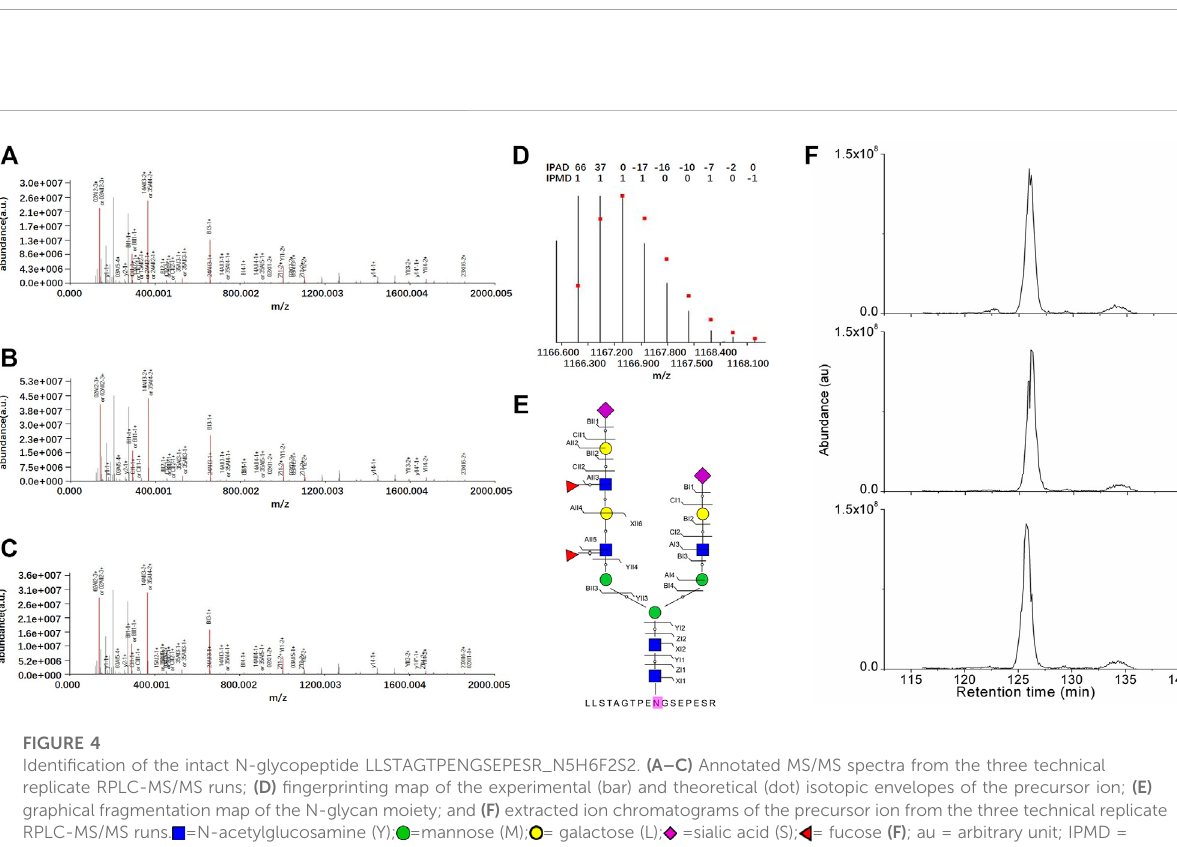
FIGURE 3 Identi fi cation of the intact N-glycopeptide GNRTENFTK_N2H8. (A – C) Annotated MS/MS spectra from the three technical replicate RPLC-MS/ MS runs; (D) fi ngerprinting map of the experimental (bar) and theoretical (dot) isotopic envelopes of the precursor ion; (E) graphical fragmentation map of the N-glycan moiety; and (F) extracted ion chromatograms of the precursor ion from the three technical replicate RPLC-MS/MS runs. = N-acetylglucosamine (Y), = mannose (M); au = arbitrary unit; IPMD = isotopic peak m/z deviation; IPAD = isotopic peak abundance deviation.